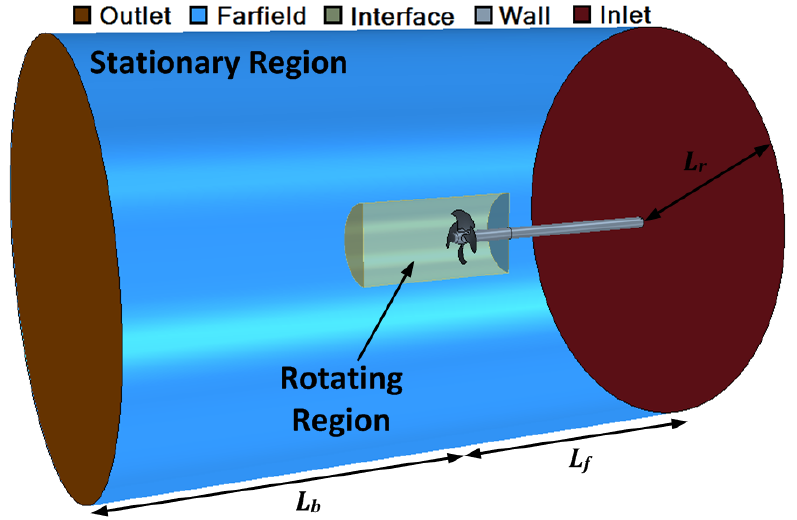
Figure 4. The domain used in the CFD simulations of the WP propeller in a non-uniform wake field. The URANS CFD simulations of the CVP propeller are made as unsteady single-phase simulations, assuming an incompressible fluid and using the segregated flow solver. The discretization order for both spatial and temporal discretization is second order. Fur- thermore, the simulations include gravity to account for the hydrostatic pressure. The turbulence is modelled using the SST k ω RANS model without the transition model, because the simulations are made using the full-scale propeller. A description of the discretization error is found in Appendix